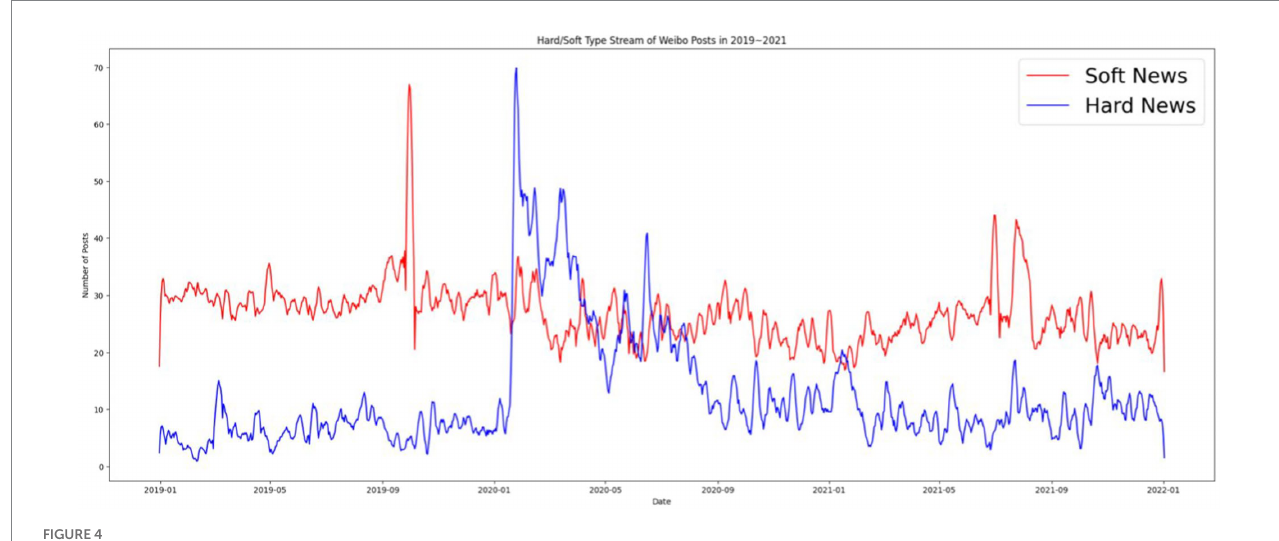
FIGURE 4 Hard and soft news on People’s Daily Weibo account from 2019 to 2021.